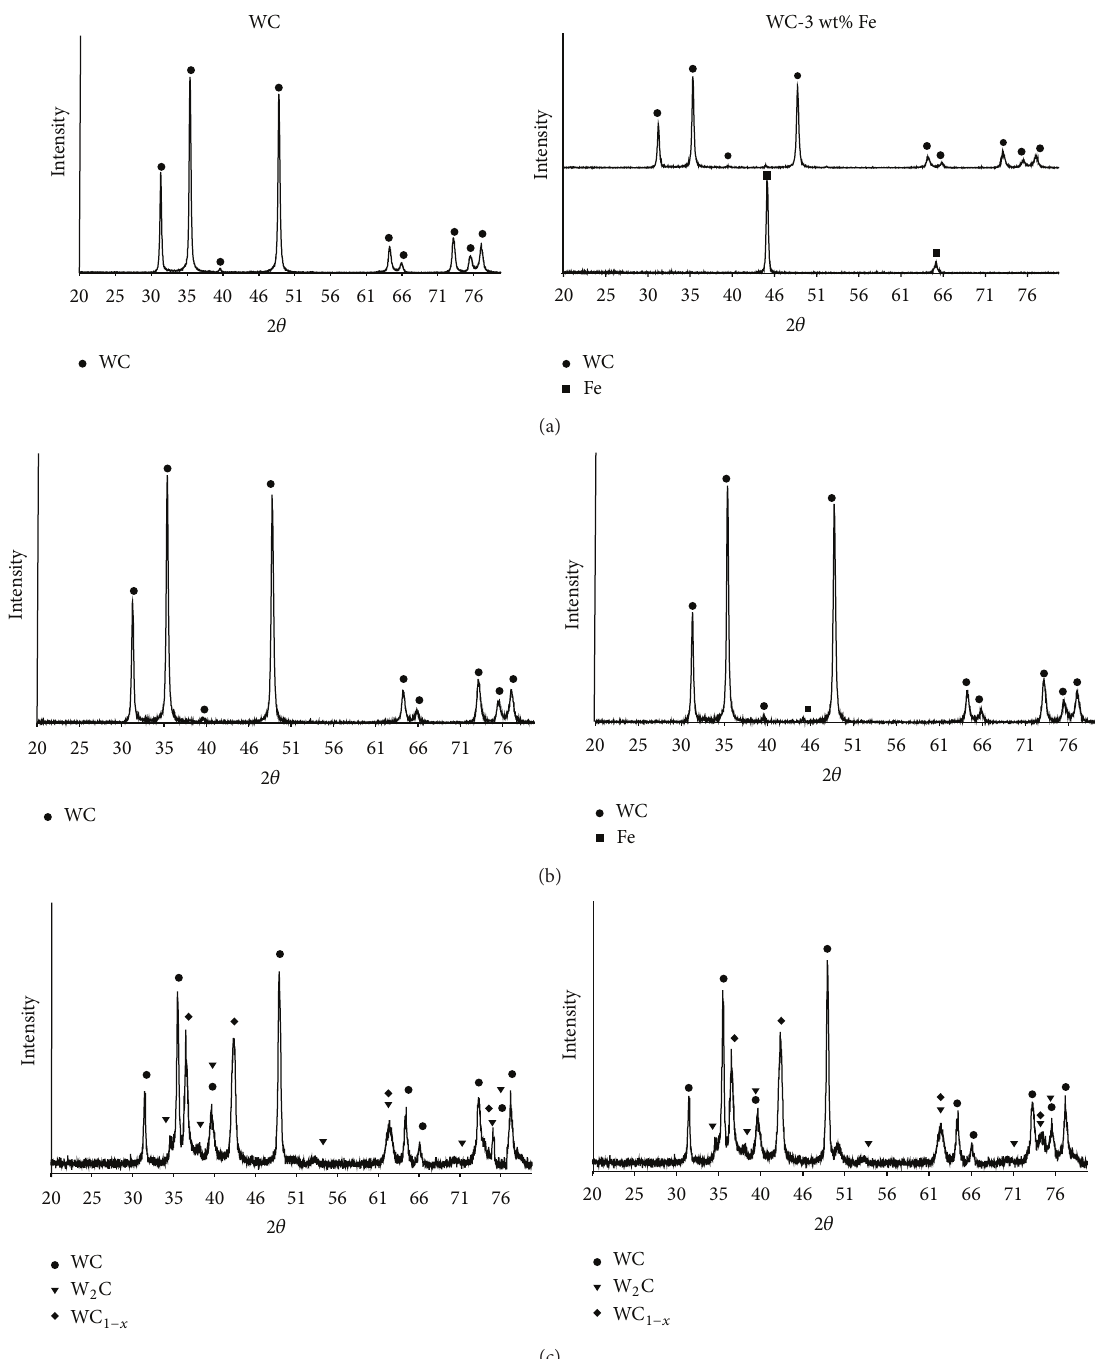
Figure 7: XRD patterns of raw powder (a), ball milled (b) and after sintering